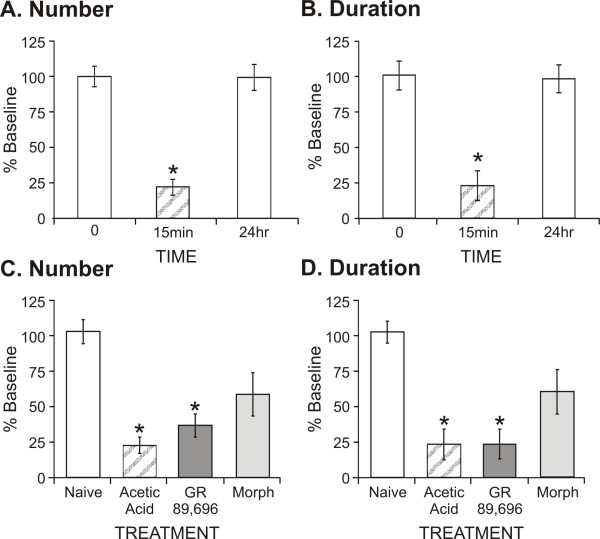
The effects of morphine and GR89,696 on reaching activity and cumulative rearing duration following visceral pain induction was determined. Acetic acid was injected (intraperitoneal) as an acute painful stimulus and produced a significant decrease (*P < 0.05, compared to baseline) in both reaching number (A) and rearing duration (B) during the first 15 min post-injection. Animals were fully recovered by 24 h, as their rearing behavior returned to baseline levels. GR89,696 (N = 8, 1.25 × 10-4 mg/kg, subcutaneous) was ineffective and morphine (N = 8, 0.5 mg/kg) was only partially effective for blocking this visceral pain induction, as demonstrated by a decrease in reaching number (C) and rearing duration (D). For (C, D), *P < 0.05 as compared to naïve animals.